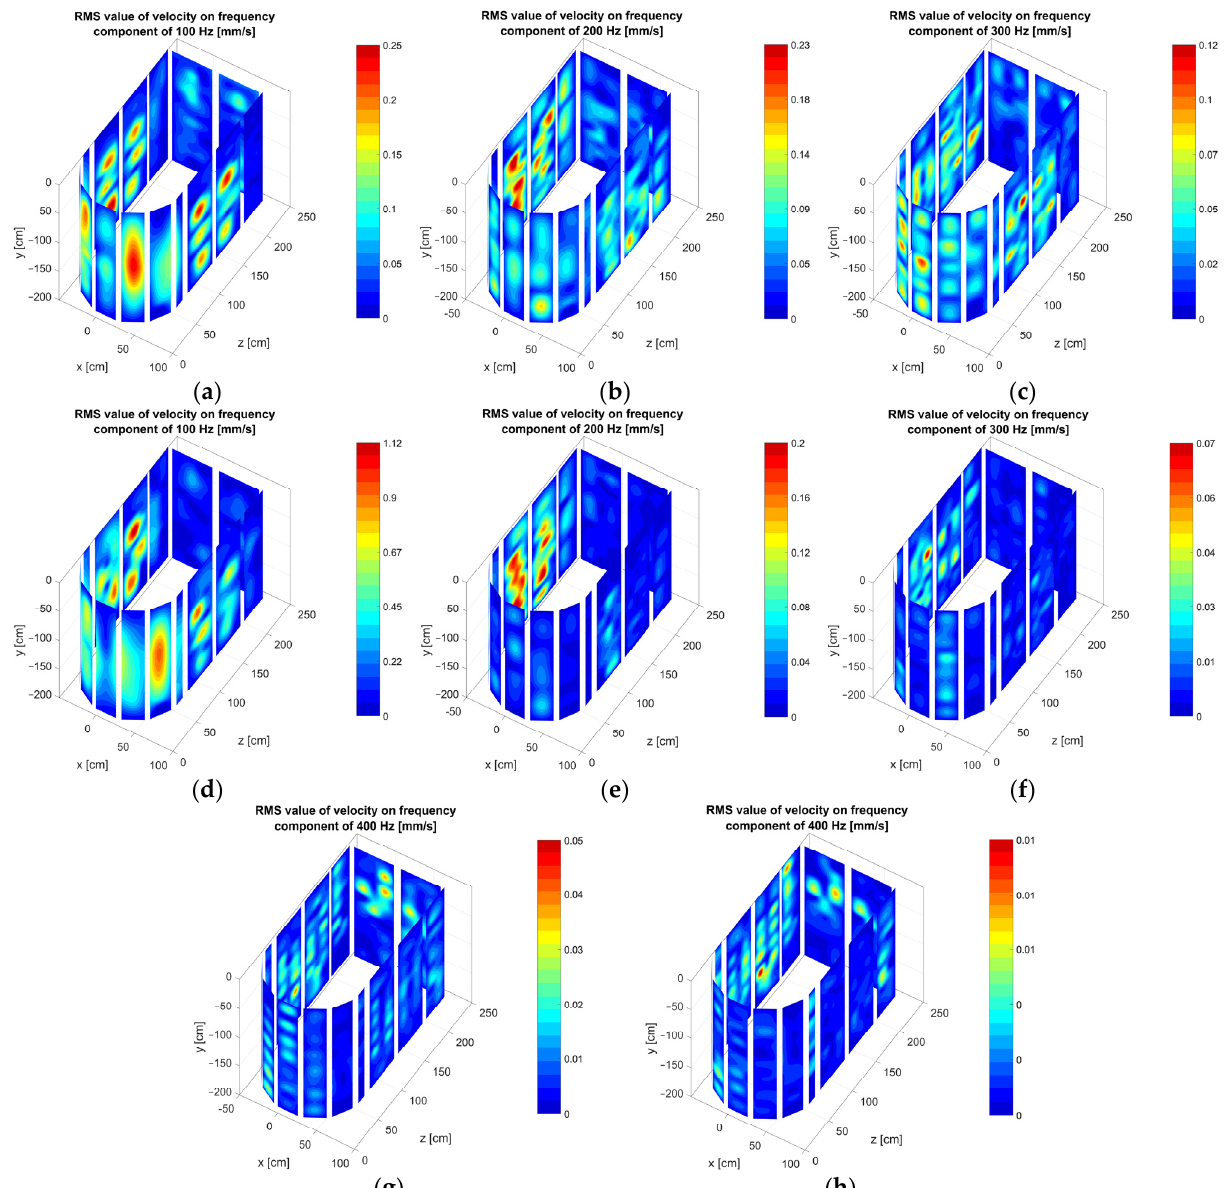
Figure 10. Visualization of RMS values of the vibration velocity in 3D space on the frequency components of 100 Hz, 200 Hz, 300 Hz, and 400 Hz in ( a – c , g ) open-circuit and ( d – f , h ) short-circuit test. Figure 11 shows instantaneous amplitudes of vibration velocity at different time moments to understand and visualize phase shifts on every transformer surface and between them. Chosen time moments correspond to every 1/8 of a period of 100 Hz, which is dominant in the short-circuit test. The vibration that can be seen is a combination of mode shapes excited at different frequencies, although it is almost only a 100 Hz component in short-circuit test. The phase shifts between different parts of the tank are also visible. Some plots (e.g., a and e, b and f, et cetera) represent the moments in time with phases shifted by 180°. Parts with red and yellow colors in one plot have dark blue and light blue colors in the other plot and vice versa. Total vibration animations at the open-circuit test and animations of different frequency components of vibrations can be visualized using the same procedure.